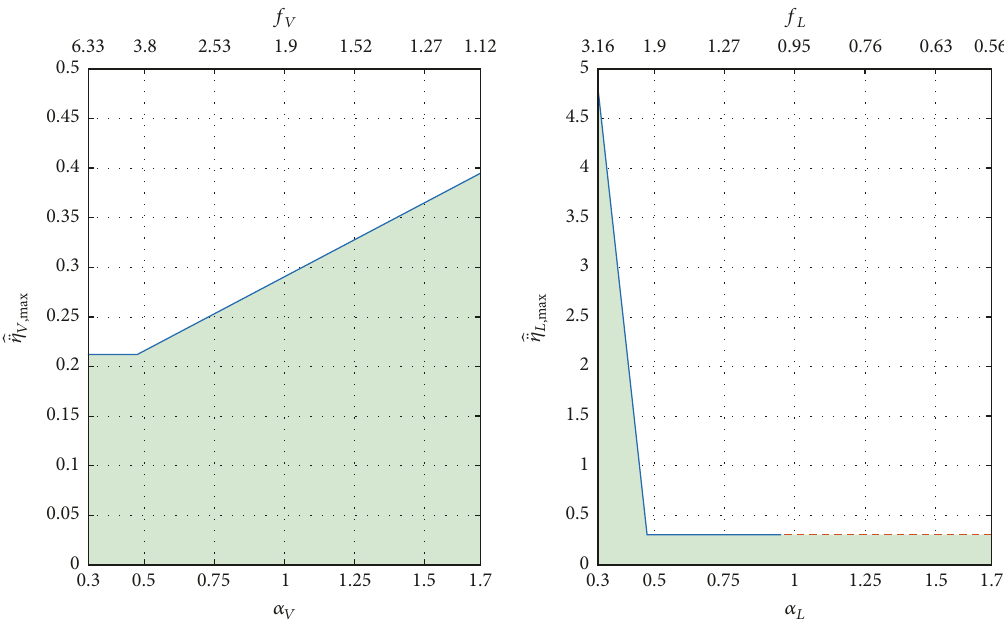
Figure 9: Threshold vertical and lateral peak acceleration using (33). The red dashed line indicates extrapolated values for 𝑓 𝐿 ≤ 1 Hz. Green areas indicate the region of acceptable comfort.